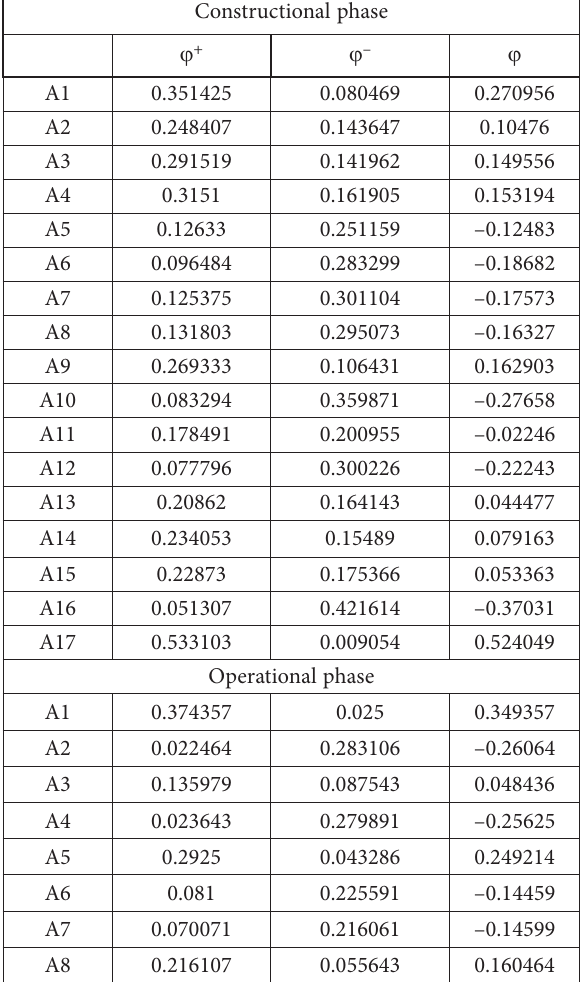
Figure 3. Alternatives outranking in constructional phase Figure 4. Alternatives outranking in operational Table 7. Positive, negative and net flows Constructional phase